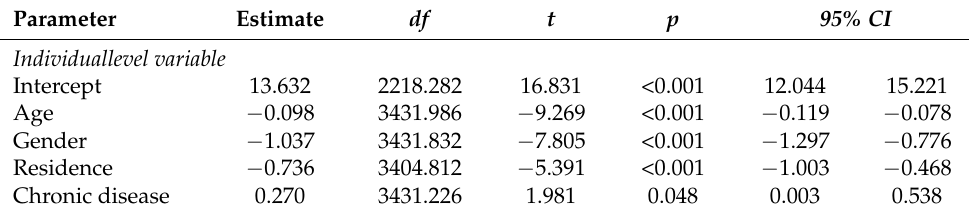
Table 8. The main effects of individual level